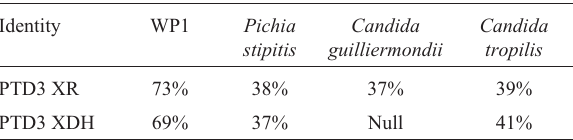
Candida Candida stipitis guilliermondii tropilis